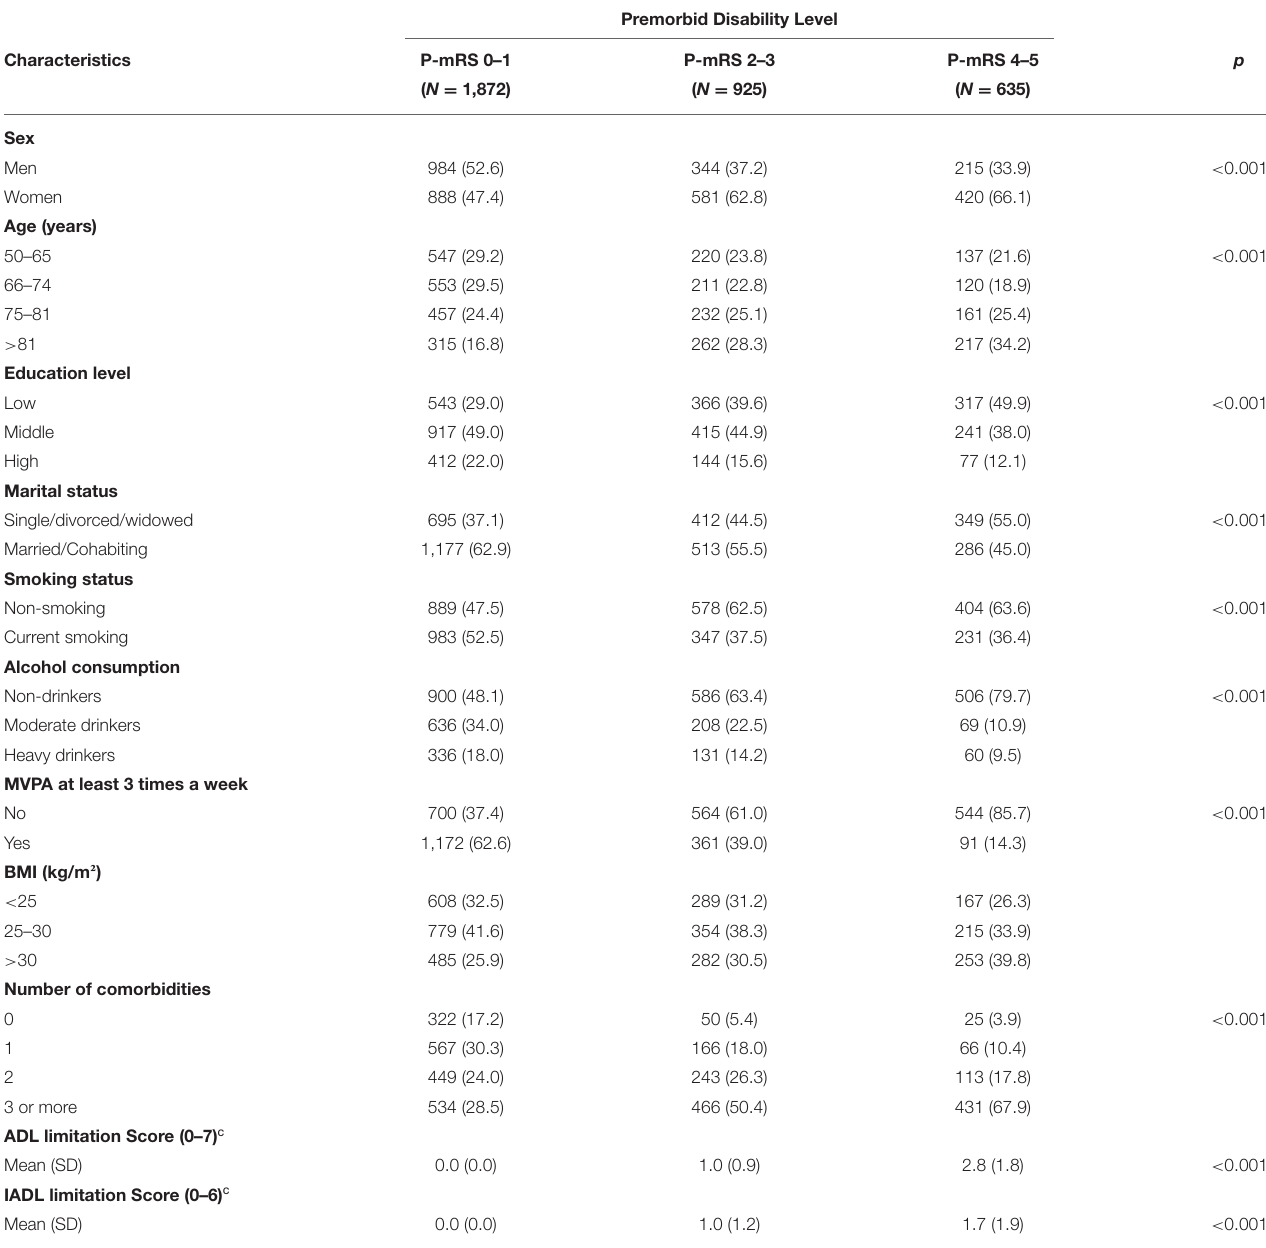
TABLE 1 | Characteristics of the study sample at last a interview before stroke onset according to premorbid disability level using modified Rankin scale (P-mRS) b